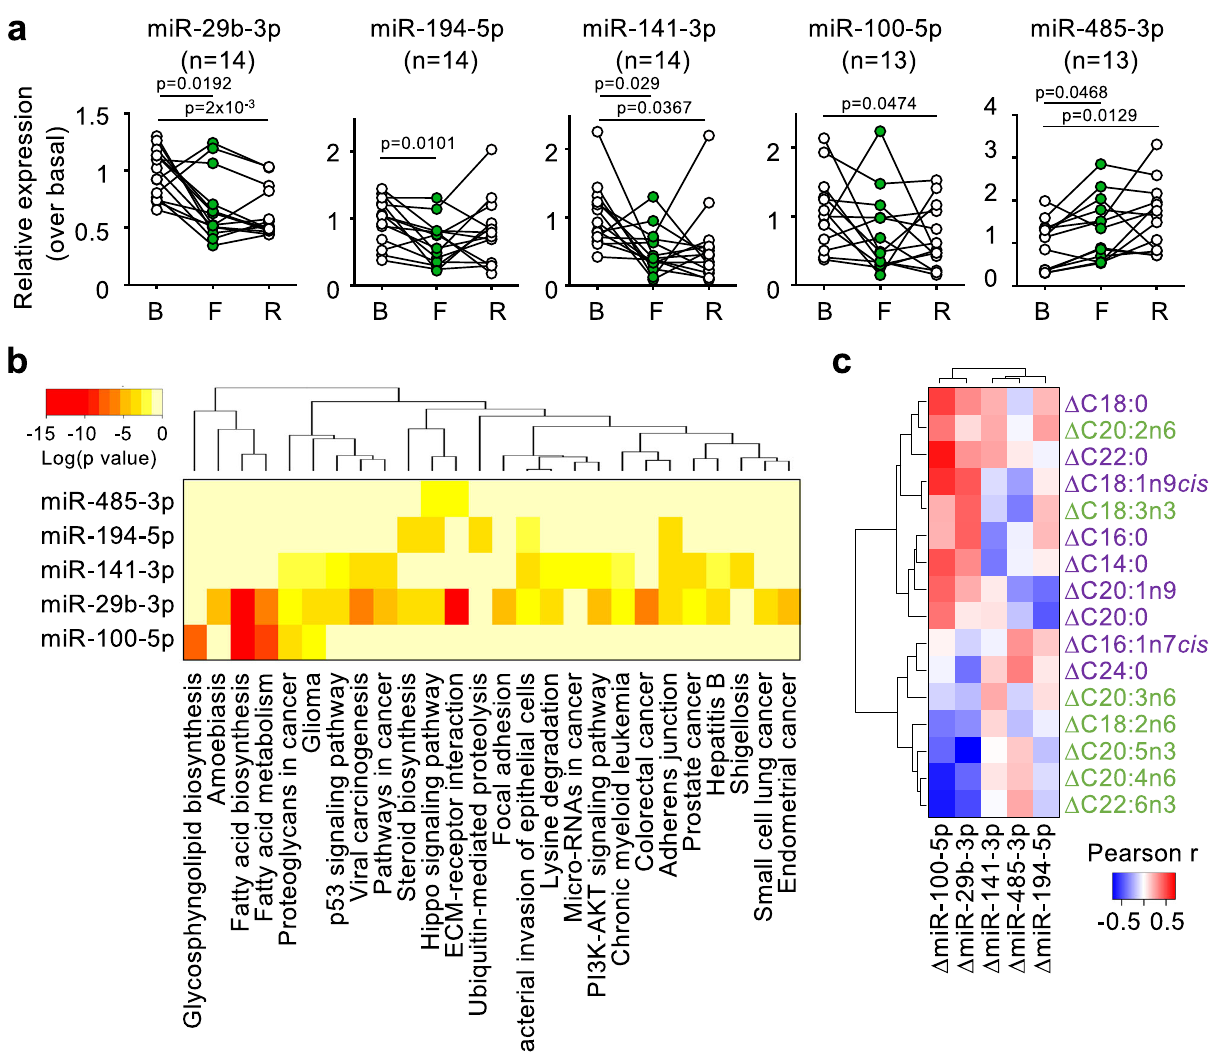
Fig. 3 | Human circulating miRNAs change during short-term fasting. a Expression of the indicated miRNAsmeasured inplasmafrom humanvolunteers at basal (B), fasting (F) and refeeding (R) points. b Heatmap showing the KEGG functions associated with genes targeted by the indicated miRNAs. c Heatmap showing the Pearson correlation r values between changes (fasting minus basal, Δ ) of all the analyzed erythrocyte membrane fatty acids and changes with fasting of the indicated circulating miRNAs signi fi cantly altered with fasting. Each dot